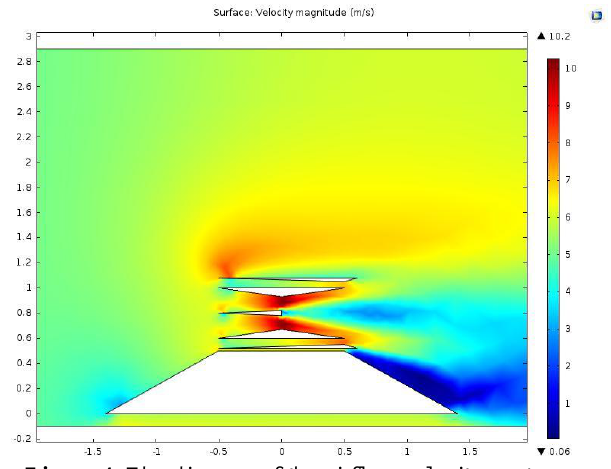
Figure 4. The diagram of the airflow velocity contours